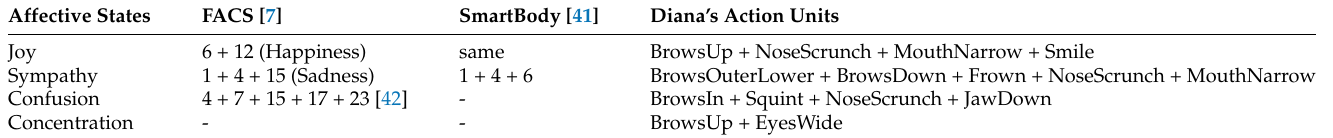
Table 1. Diana’s action unit code combinations compared with other code combinations.